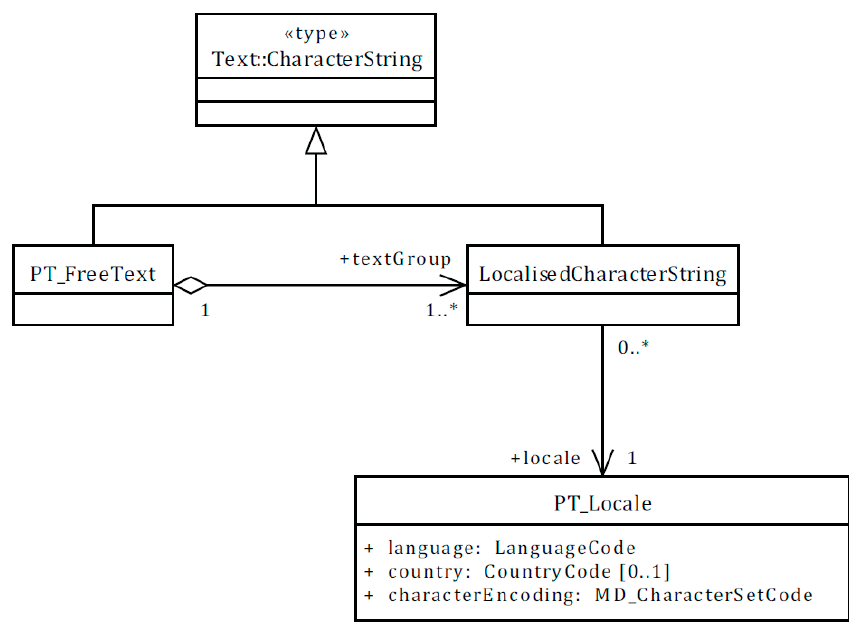
Figure 3. ISO 19115-1 structure to support cultural and linguistic capability.